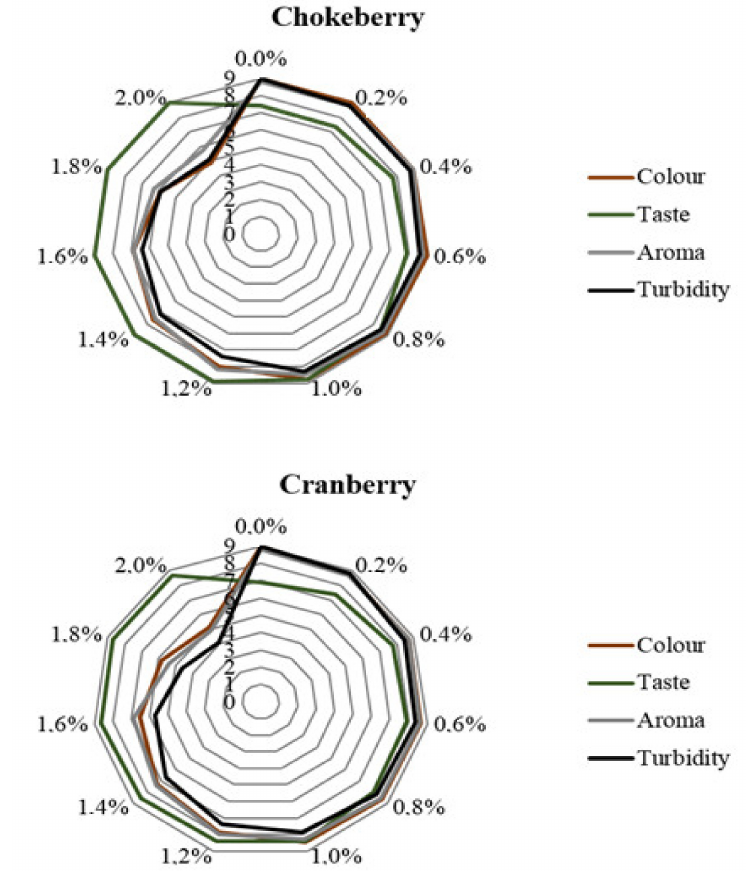
Figure 7. Sensory analysis in products with CESP before thermal